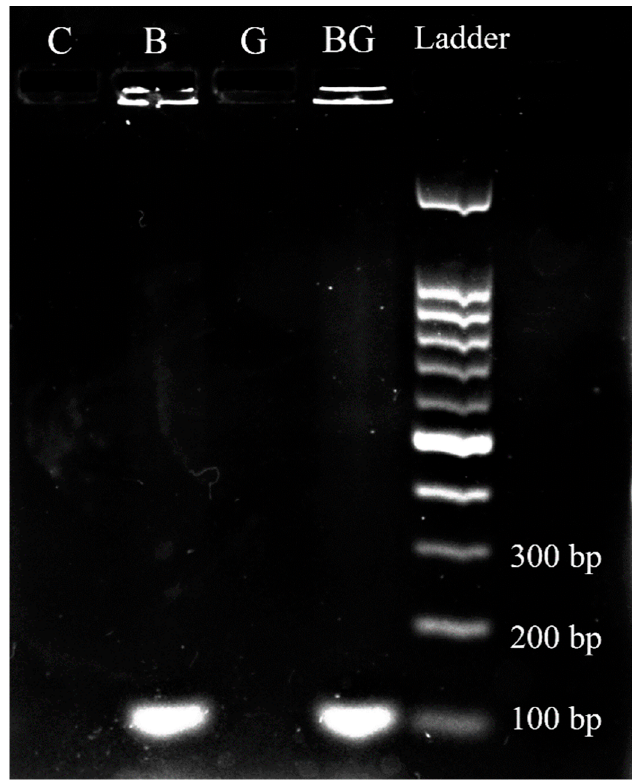
Figure 7. Gel electrophoresis of sarcosine oxidase. PCR amplification of the sarcosine oxidase gene product visualized in a 1.7% agarose gel. Table 3. Blastn results for the PCR products.